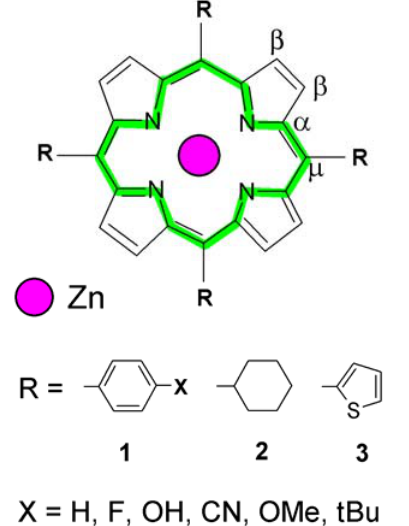
Figure 1. General structure of the tetra- meso -substituted Zn-porphyrins (OMe = methoxy; tBu = tert- butyl).